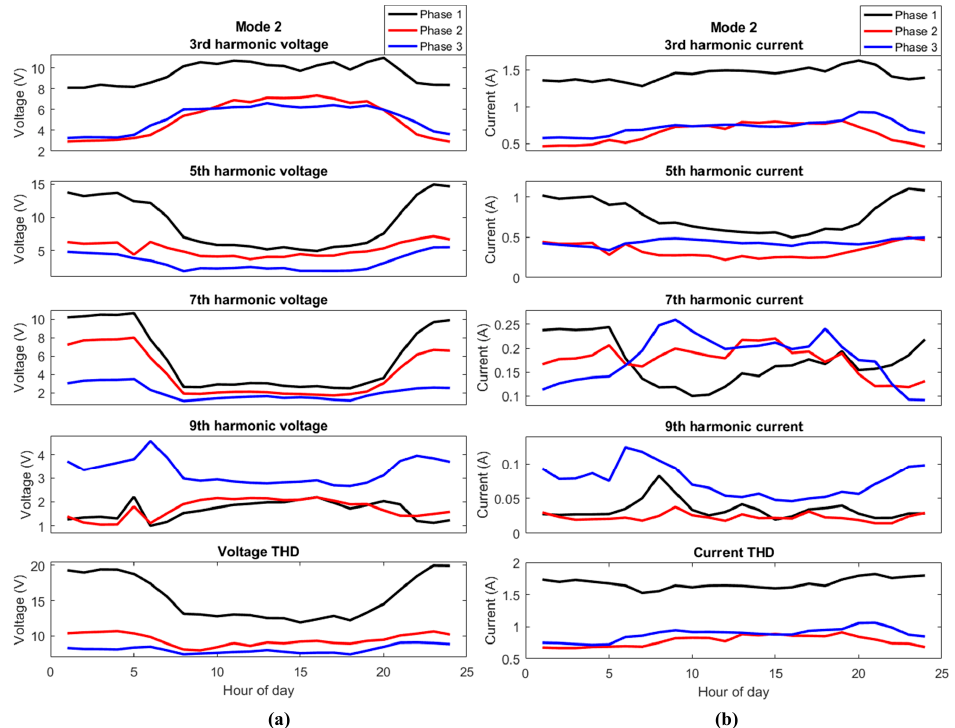
Figure 19. ( a ) The odd harmonic voltage 3rd to 9th and THD for mode 2 in Figures 14–16. ( b ) The odd harmonic current 3rd to 9th and THD for mode 2 in Figures 14–16. The average values are grouped for each hour of the day for around 8 weeks of islanded operation. Note also the difference in vertical scale for the different plots. Energies 2018 , 11 , x FOR PEER REVIEW